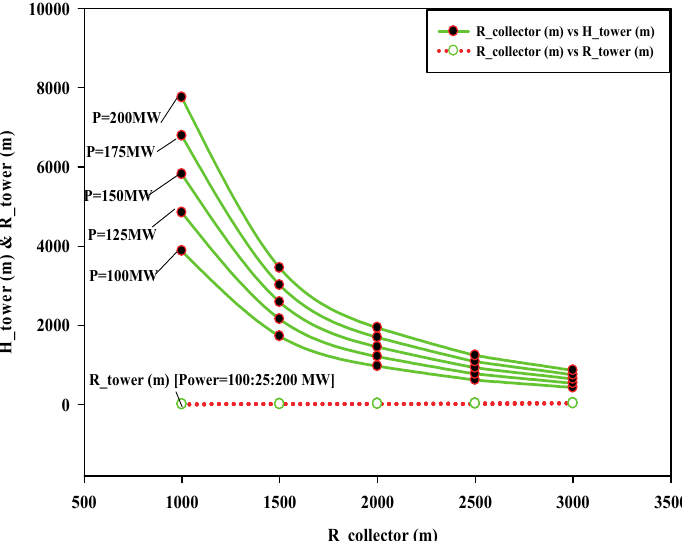
Figure 11. Effect of variation in collector radius ( R Collector ) on tower height ( H Tower ) and tower radius ( R Tower ) for fixed power output of SUTPP.